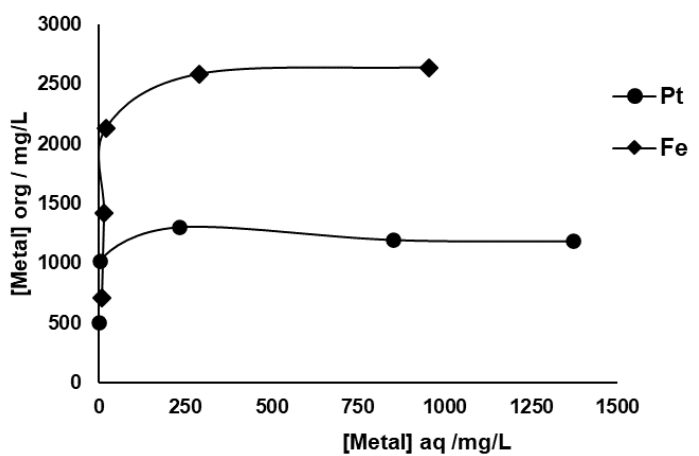
Figure 4. Equilibrium extraction isotherms obtained for 0.25 M DMDCHTDGA in toluene towards Pt and Fe from a SACC leaching solution.